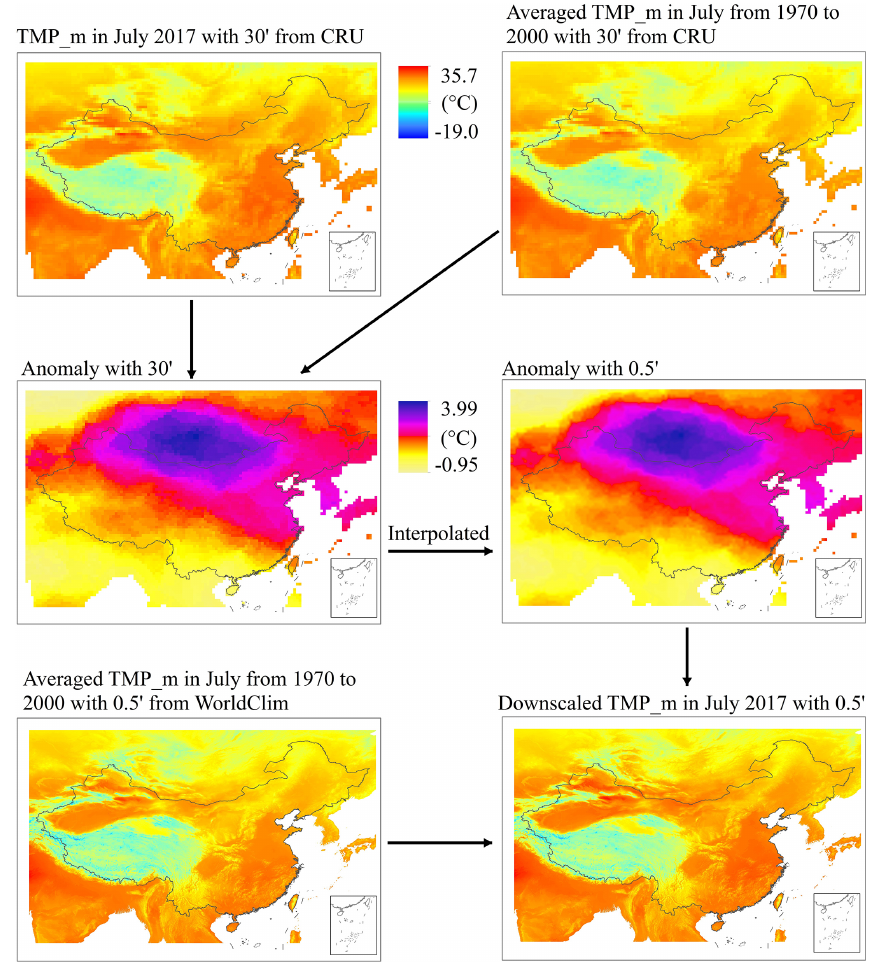
Figure 3. Schematic illustration of the delta spatial downscaling process using the mean TMP (TMP_m) in July 2017 obtained from the CRU data as an